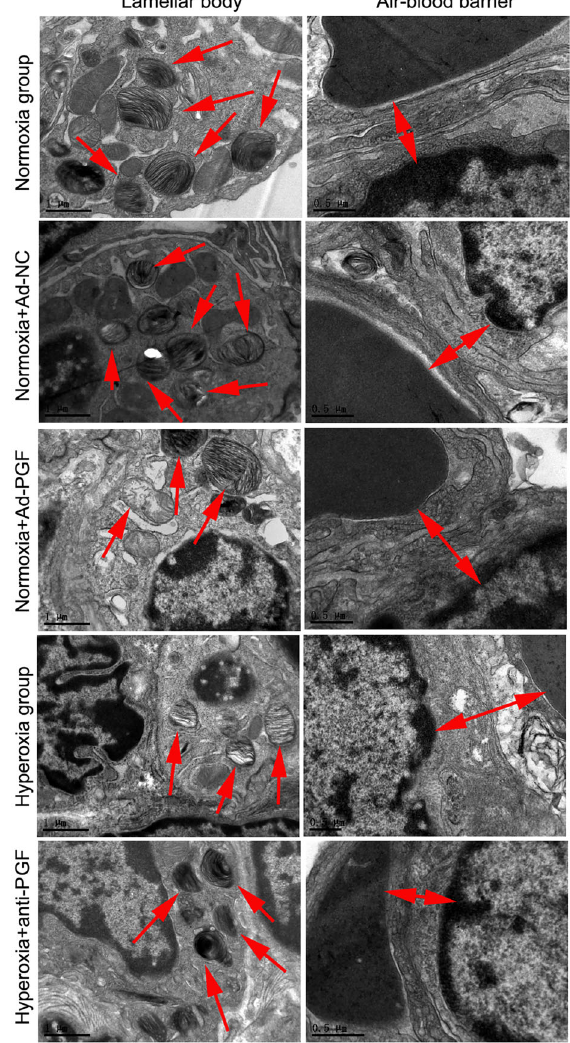
Figure 5. The ultrastructure of alveolar epithelial cells (arrows) of newborn rats of each indicated group (n=10). Scale bars in left images: 1 m m; scale bars in right images: 0.5 m m. PGF: placental growth factor; Ad-NC: adenovirus-negative control; Ad-PGF: adenovirus-placental growth